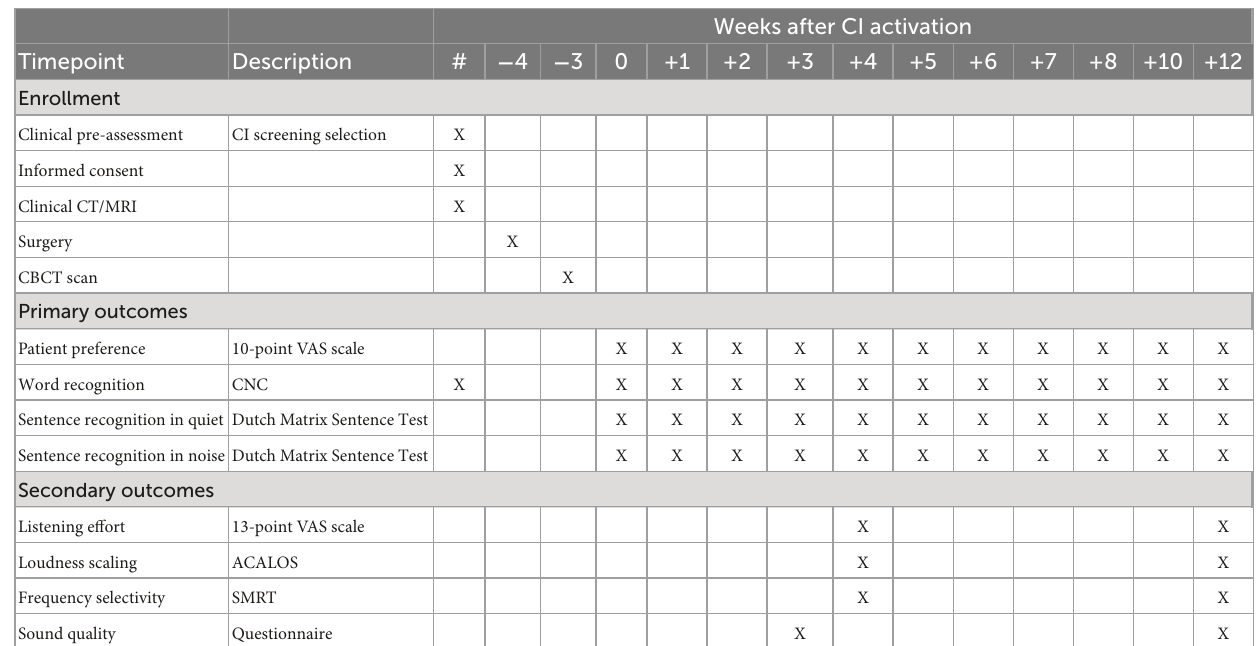
TABLE 1 Schedule of enrollments and measurements where timepoint 0 represents CI activation (+0